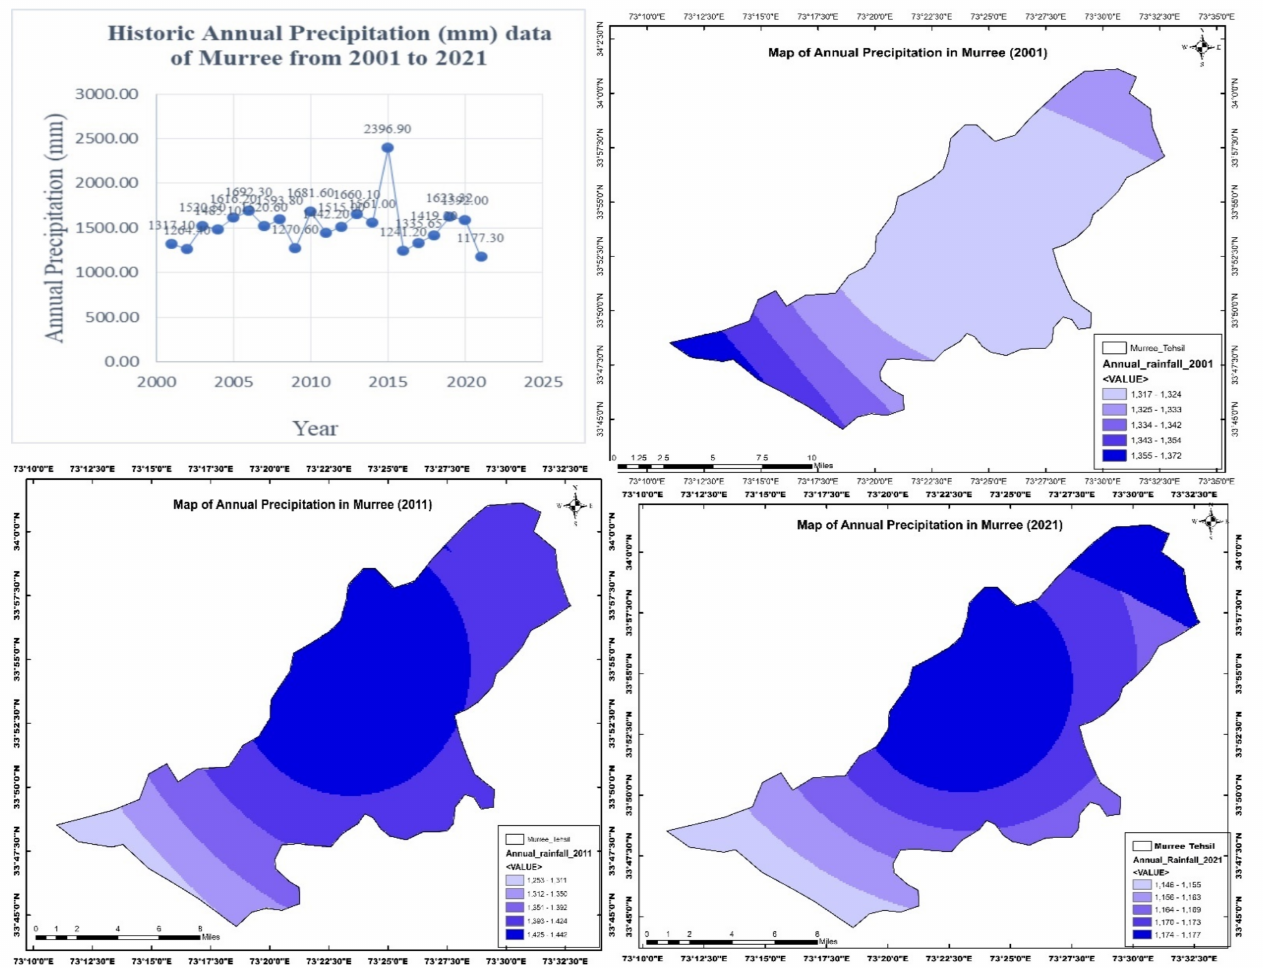
Figure 7. Annual precipitation (mm) data and precipitation distribution of Murree from